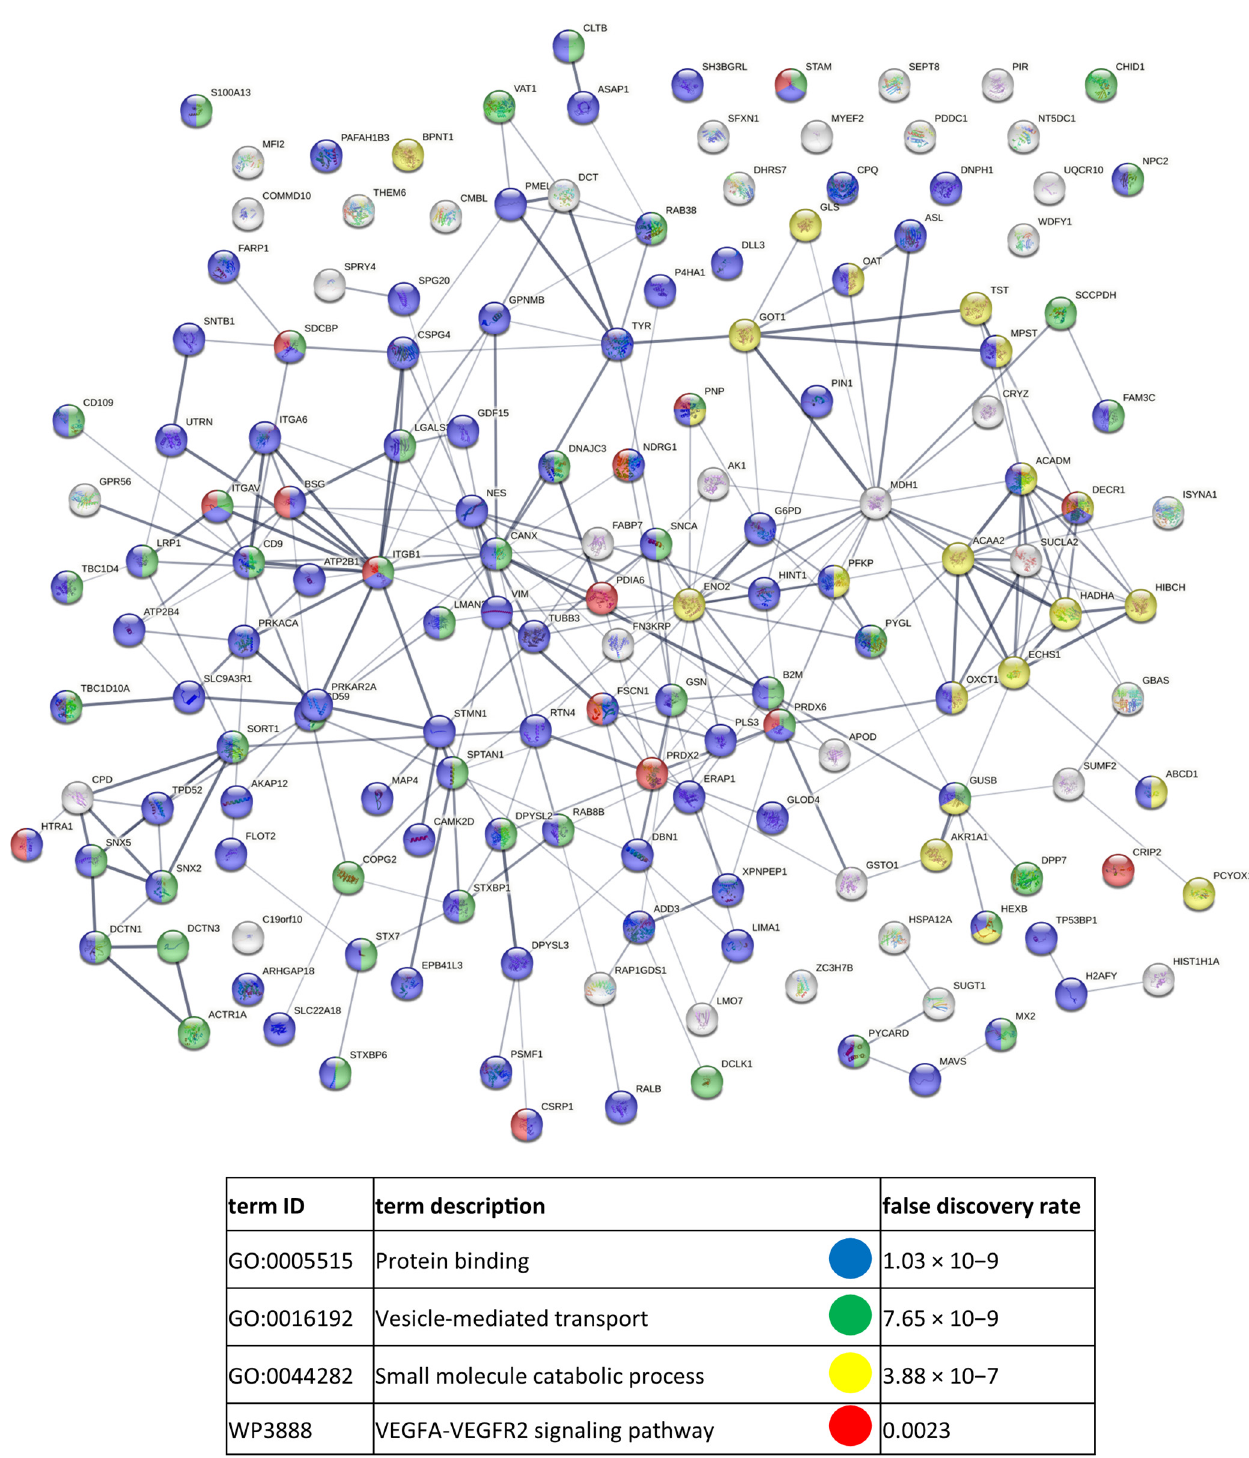
Figure A10. Diagram of functional protein association networks prepared with the use of STRING v. 11.0 software for proteins upregulated in WM115 cells vs. WM266-4 cells. The selected, strongly represented pathways are presented as an interactome. Proteins with fold change > 1.5 were con- sidered upregulated in WM115 cells ( p < 0.001). A complete analysis is presented in Supplemen- tary Data S3.